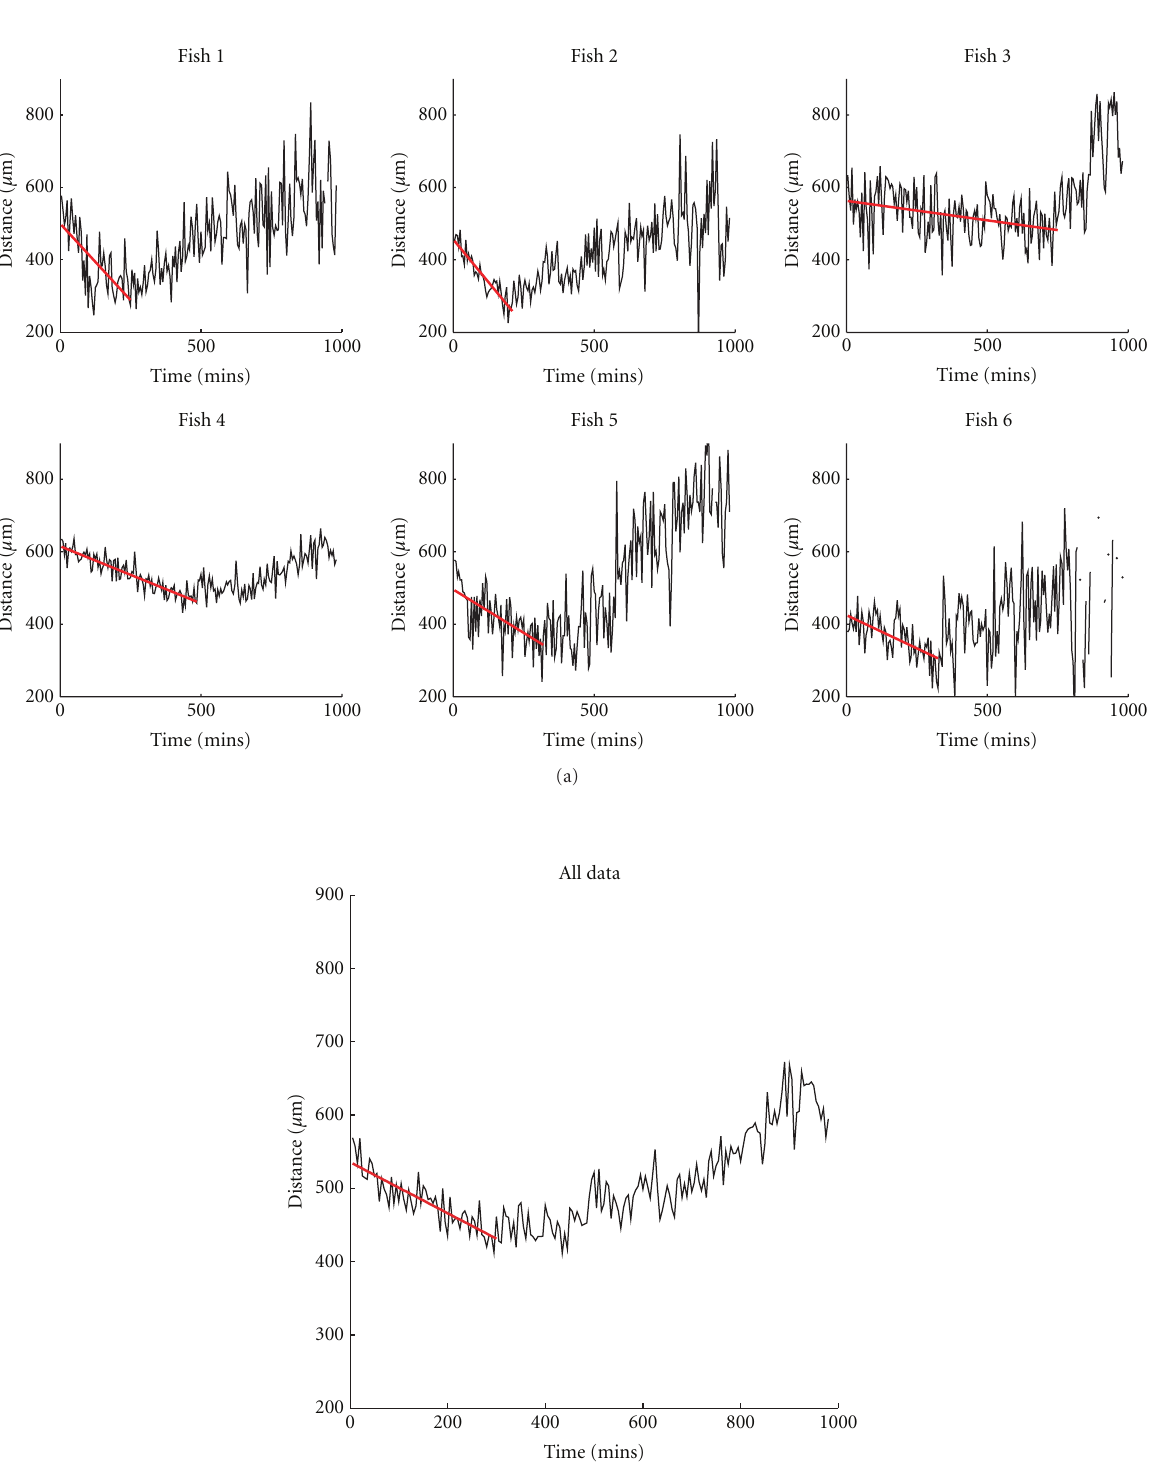
Figure 3: Nonphotoconverted neutrophils actively migrate into the wound region. (a) Variation over time of mean cell distance from the wound for the nonphotoconverted (green) neutrophils, observed in each subject 1–6 (black line). Overlaid on each graph is the prediction of mean distance obtained from the linear model used to characterise the initial drift (red line). The time is measured from the start of observations which commenced 4 hours after injury. The cell count in subject 6 (bottom right) was low and sometimes zero near the end of the dataset, which explains the missing sections. (b) Data and model combined over all